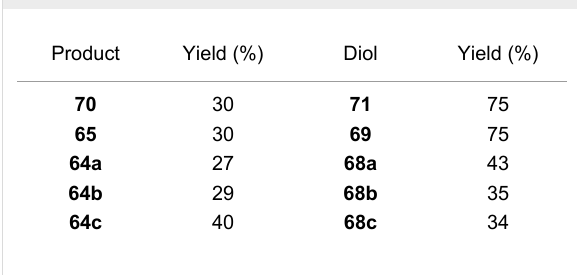
Table 4: Yields of the products 64 , 65 , 68 – 71